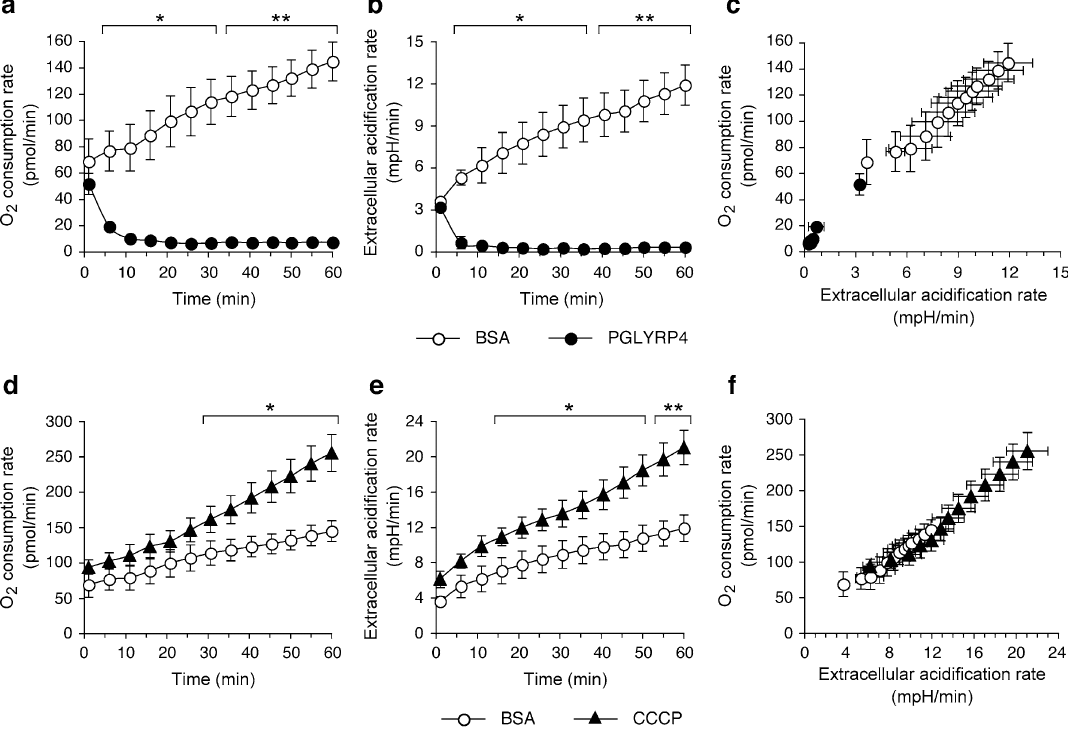
Figure 6. Oxygen consumption and extracellular acidification rates in PGLYRP4- or CCCP-treated B. subtilis . ( a , d ) O 2 consumption rate and ( b , e ) extracellular acidification rate were measured simultaneously in real time with the Seahorse XFp analyzer in B. subtilis 6633 treated with 100 µg/ml BSA, or 100 µg/ml PGLYRP4, or 1 µM CCCP. ( c , f ) Phenograms of O 2 consumption rate plotted versus extracellular acidification rate illustrate the total cell energy phenotype. The results are means of 3 experiments ± SEM (SEM were within symbols if not visible); * P < 0.05, ** P < 0.001, PGLYRP4 or CCCP vs to the decreasing O 2 consumption rate) and was significantly lower and almost at the baseline already after 6 min of PGLYRP4 treatment (Fig. 6b). By contrast ECAR steadily increased in BSA-treated B. subtilis cells throughout the entire 60-min incubation period, which reflected healthy cell growth and was significantly higher than in PGLYRP4-treated cells at 6 to 60 min (Fig. 6b). As expected, ECAR was also significantly higher in CCCP-treated cells than in BSA-treated cells at 16 to 60 min, consistent with higher respiration rate in CCCP- than in BSA- treated cells (Fig. 6e). Plotting O 2 consumption rate versus ECAR illustrates the total cell energy phenotype and shows low-energy phenotype in PGLYRP4-treated cells (Fig. 6c), consistent with eventual energy depletion and impending death 9 , in contrast to the control cells incubated with BSA or CCCP, which had high-energy state (respiration and metabolism) (Fig. 6c,f). These results show that PGLYRP4 induces a malfunction and eventual shutdown of the respiratory chain in B. subtilis . We obtained similar results (decreased O 2 consumption rate and ECAR) in PGLYRP4-treated E. coli 11 , which suggests that the effect of PGLYRP4 on respiration is conserved in Gram-positive and Gram-negative bacteria. E. coli ubiquinone, cytochrome bd ‑I, and formate and NADH dehydrogenases are required for PGLYRP4‑induced thiol depletion. The above results motivated us to investigate whether the respiratory electron transport chain also plays a role in PGLYRP4-induced thiol depletion in Gram-negative bacteria, using E. coli as a model. E. coli has a complex respiratory electron transport chain that contains 15 dehydrogenases that can deliver electrons to 3 quinones, and 14 terminal reductases that can deliver electrons to 8 different electron acceptors, including 3 terminal cytochromes ( bo 3 , bd -I, and bd -II) 25,34 . We have already recently shown that in E. coli both NADH dehydrogenases (NDH-1 and NDH-2), formate dehydrogenase-O (FDH-O), ubiquinone (UQ), and cytochrome bd -I are all required for PGLYRP4-induced killing and oxidative stress 11,26 , but the role of the respiratory chain components in PGRP-induced thiol stress in E. coli was unknown and was the subject of our next experiments. Given the prominent role of MK and cytochrome aa 3 -600 in PGLYRP4-induced killing and thiol depletion in B. subtilis , we first tested whether quinones and cytochromes were involved in PGLYRP4-induced thiol deple- tion in E. coli . E. coli has 3 quinones: UQ, MK, and DMK and we next tested whether any of these quinones are involved in PGLYRP4-induced thiol depletion. In E. coli UQ is synthesized by a separate pathway than MK and DMK, but the synthesis of MK from DMK uses the same enzyme (UbiE) that is also used in the synthesis of UQ 35 . Thus, mutants lacking only UQ (Δ ubiCA ), both UQ and MK (Δ ubiE ), or both MK and DMK (Δ menA )